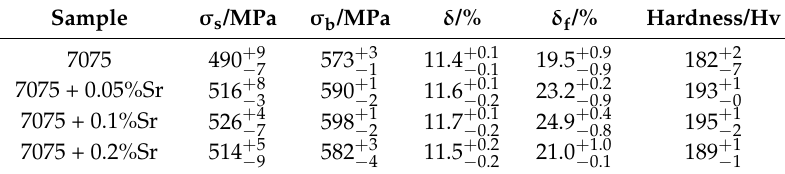
Table 1. Mechanical properties of 7075 T6 alloys without and with different contents of Sr (wt. %). Sample